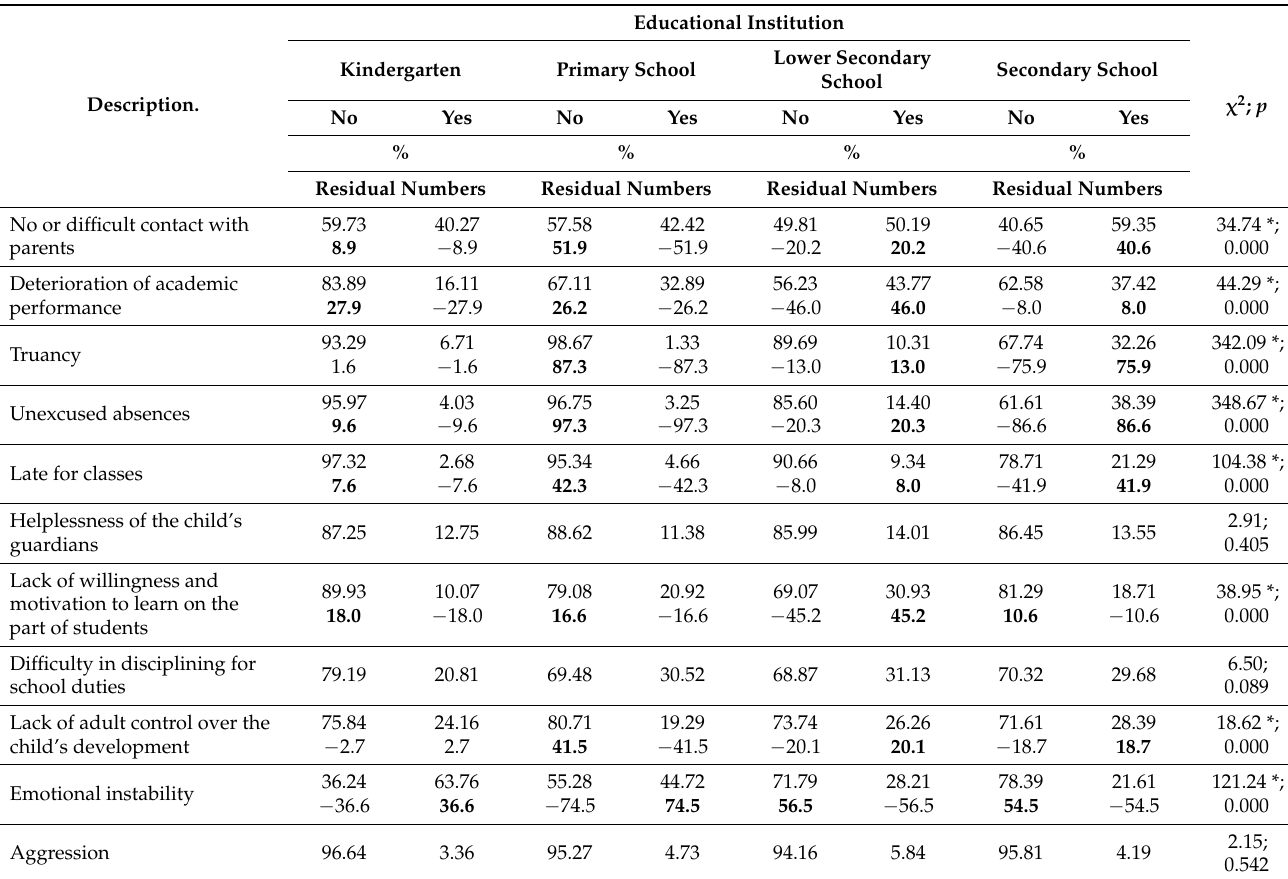
Table 3. Differentiation of difficulties faced by an educational institution with students whose parents have gone abroad.